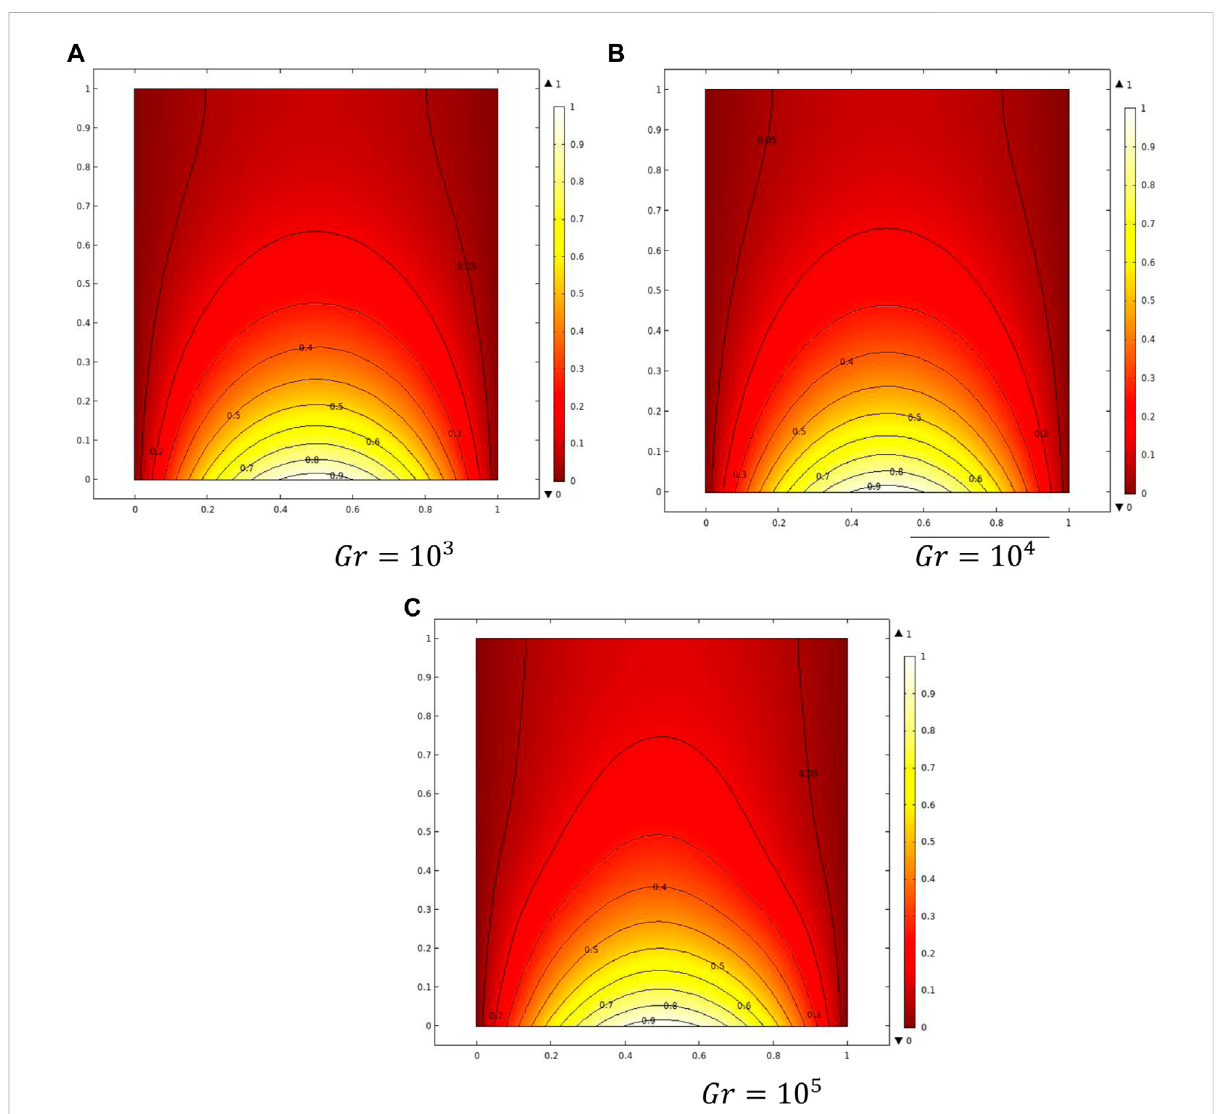
FIGURE 12 In fl uence of Gr on temperature with non-uniform heating: (A) Gr (cid:1) 10 3 , (B) Gr (cid:1) 10 4 , and (C) Gr (cid:1) 10 5 .